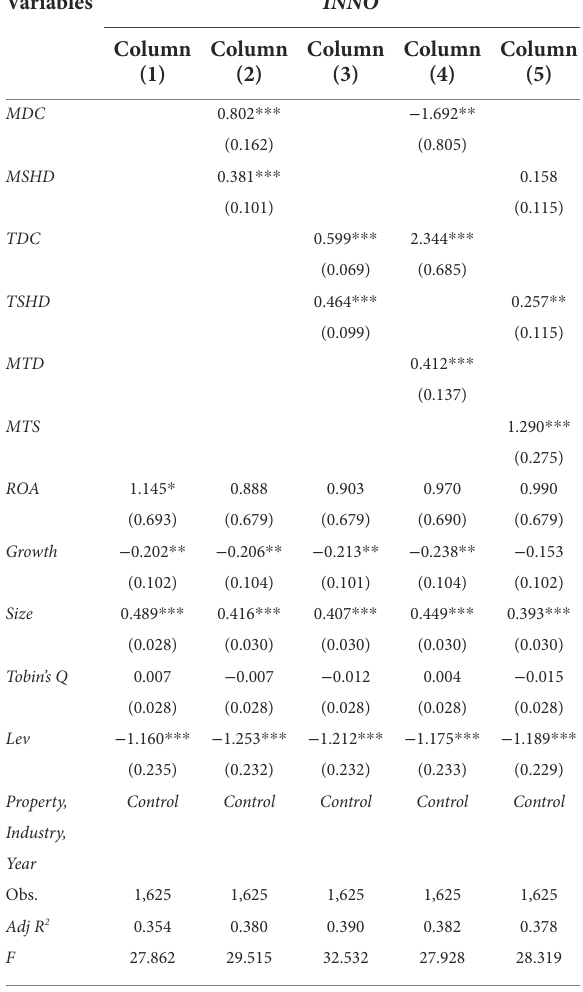
TABLE 3 The interactive impact of dual talent flow network on firms’ innovation. Variables